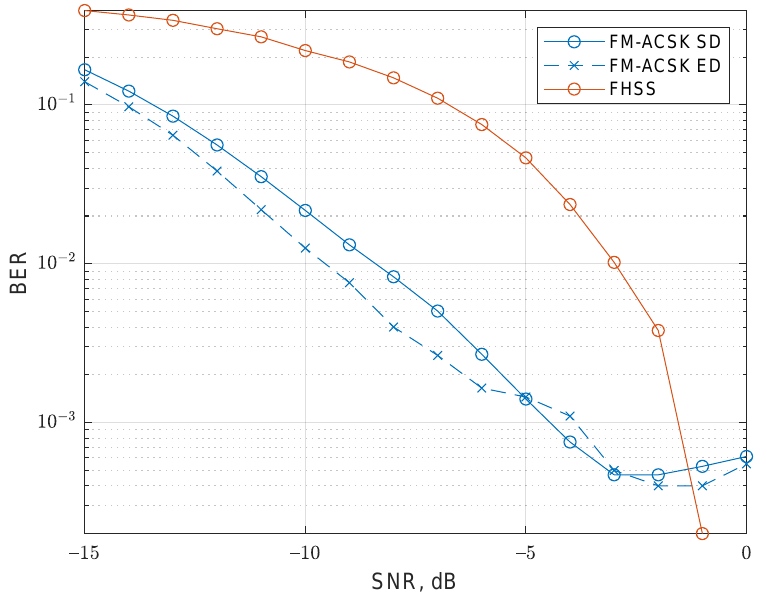
Figure 18. BER versus SNR for data transmission with FM-ACSK and FHSS. SD—strobe-based detector; ED—energy-based detector. FM deviation is 10